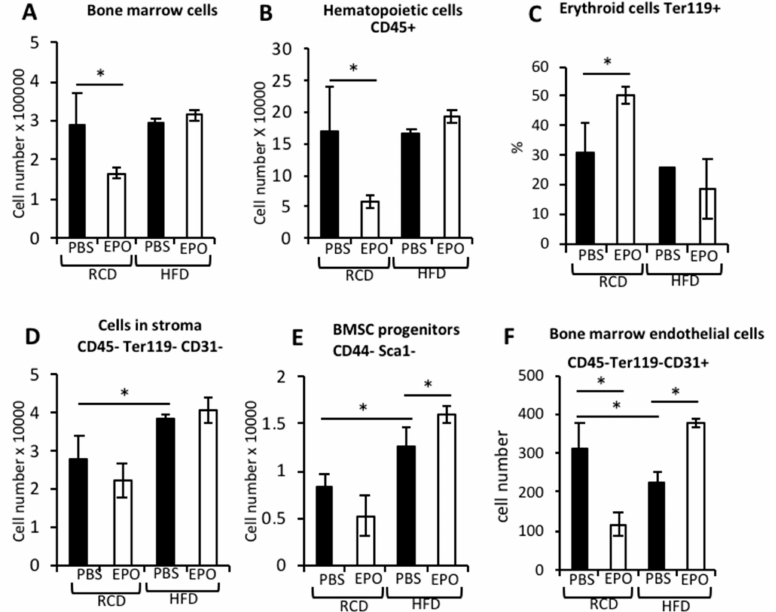
Figure 5. EPO administration in HFD-fed mice restores bone marrow cell populations. ( A ) The total number of bone marrow cells (minus red blood cells and adipocytes) analyzed by flow cytometry. ( B , C ) Flow cytometry analysis of bone marrow cells stained for the pan-hematopoietic marker CD45 ( B ) and erythroid specific glycophorin A, detected by a Ter119 antibody ( C ). ( D ) The total number of cells that are negative for CD45, Ter119 and CD31, considered as cells occupying bone marrow stroma. ( E ) The number of BMSC progenitors negative for CD44 and Sca1 in the CD45-Ter119-CD31- bone marrow stroma. ( F ) The number of bone marrow endothelial cells which are negative for the hematopoietic marker CD45, negative for erythroid marker Ter119 and positive for endothelin marker CD31. ( n = 3—6 / group), * p <